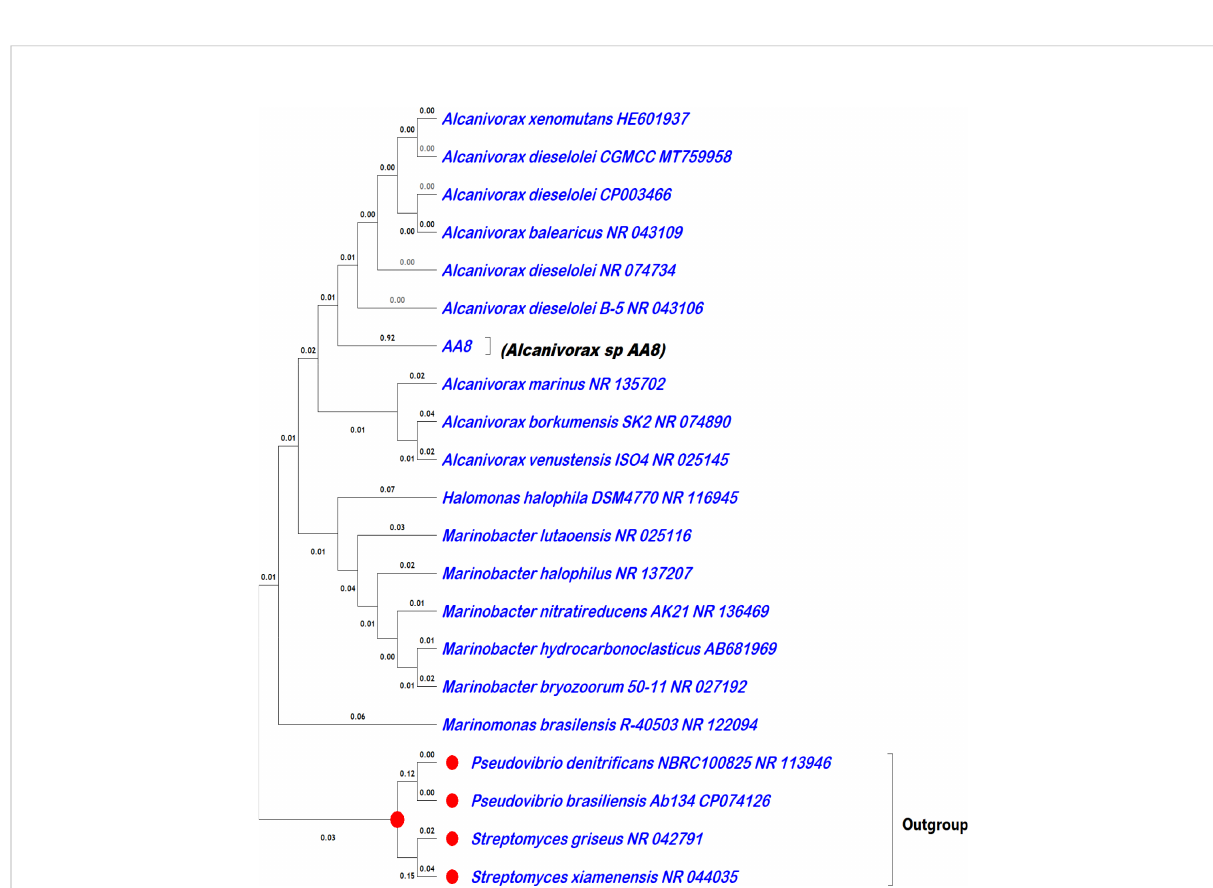
FIGURE 2 Phylogenetic tree constructed using MEGAX. The organism isolated in this study was labeled as AA8 with the full name of the organism in brackets.